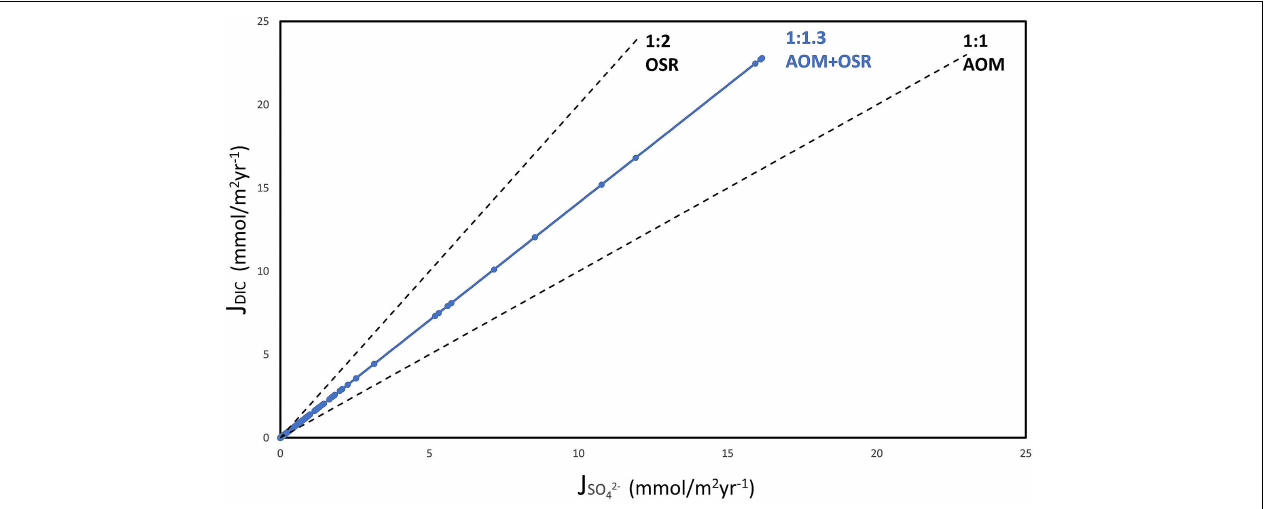
FIGURE 3 | Plots for SO 42 - : DIC ratio for AOM and OSR. Black slopes indicate AOM (1:1) and OSR (1:2). The blue slope indicates SO 42 - : DIC plot calculated from 740 diffusion-controlled marine methane flux sites globally by Egger et al. (2018), with SO 42 - flux data from 509 sites. CH 4 concentrations were adjusted using a 1:1.4 flux ratio for CH 4 : SO 42 - and the combined effect of AOM and OSR results in a SO 42 - : DIC ratio ∼ 1:1.3.